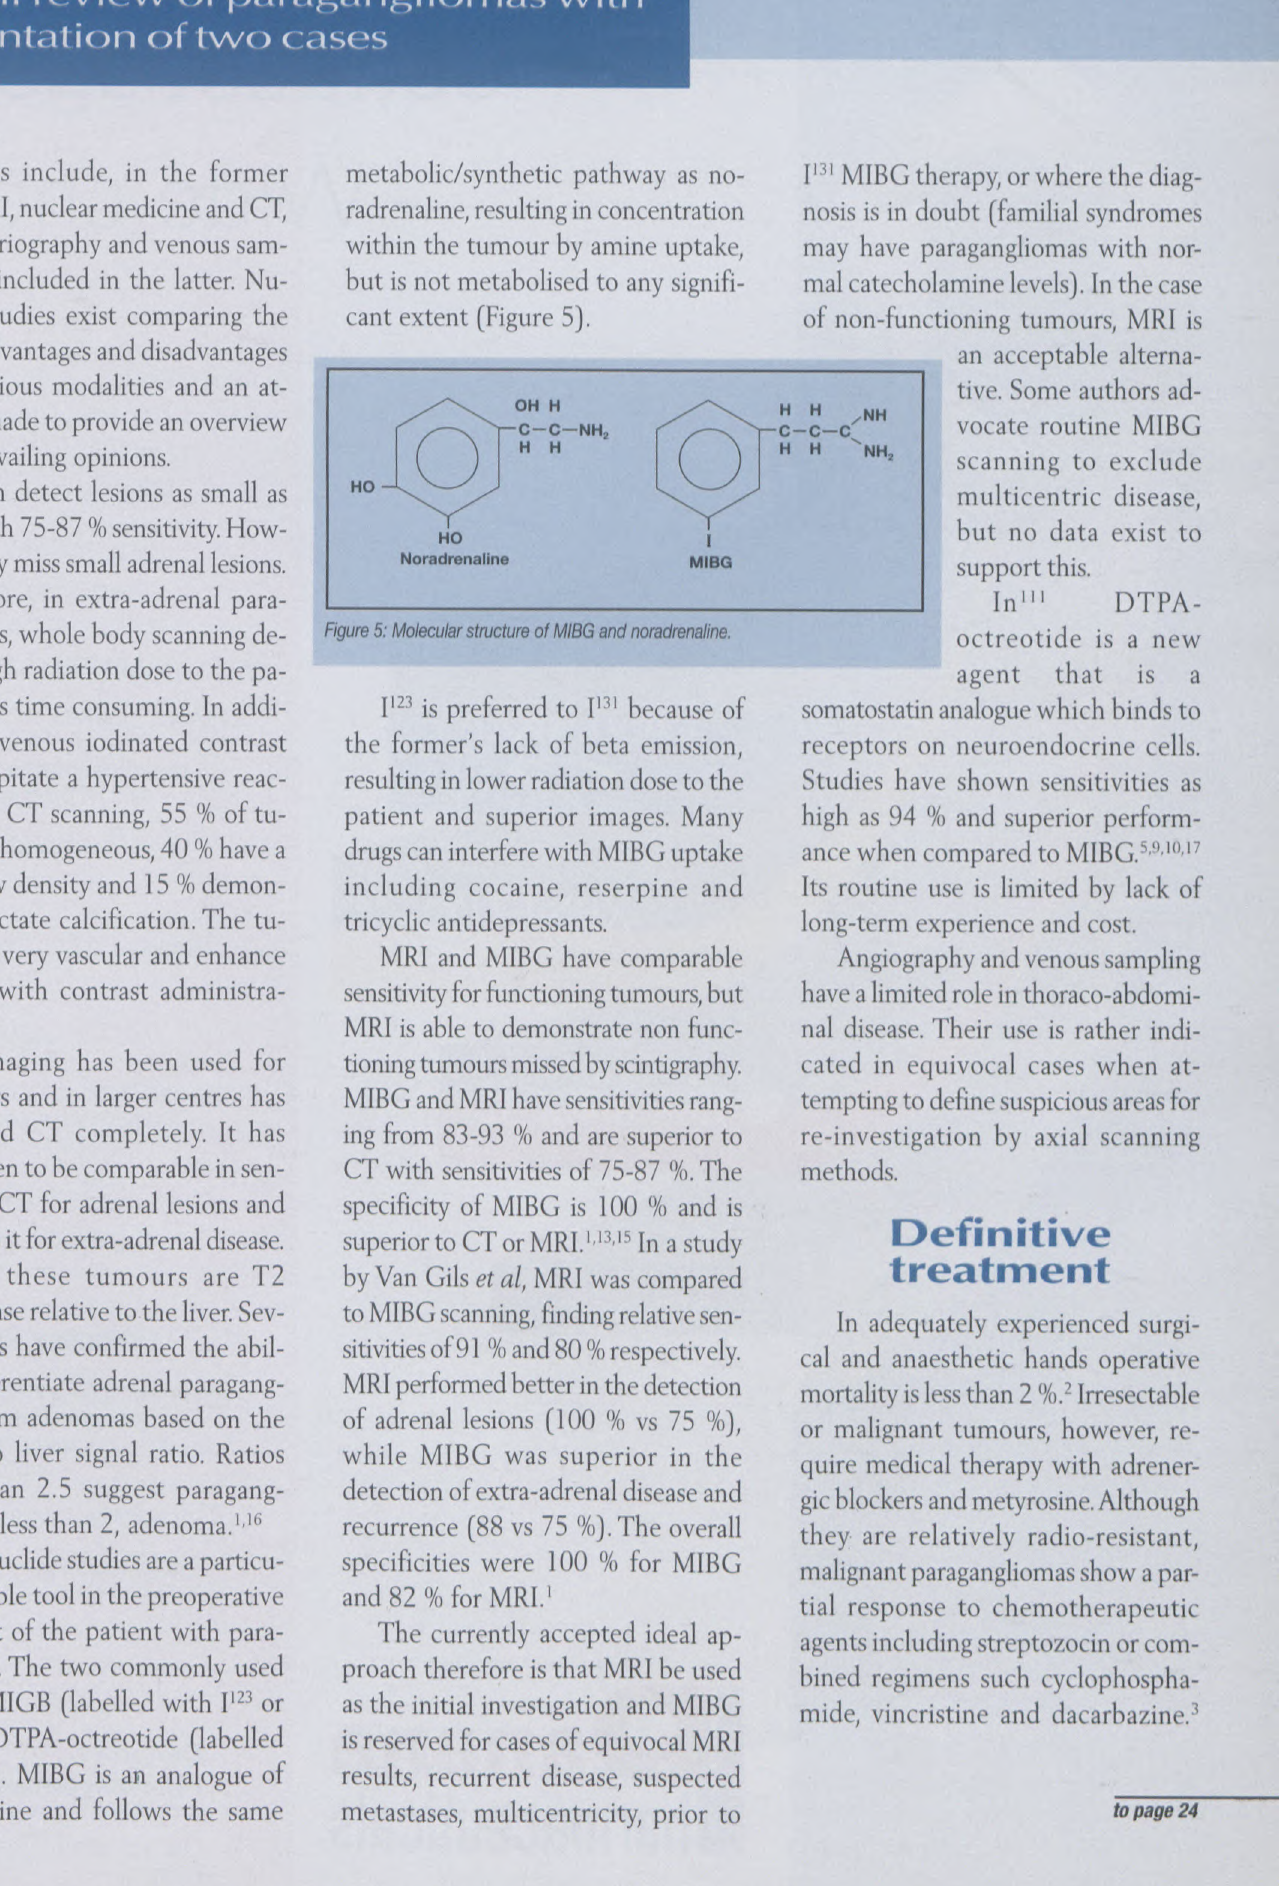
Figure 5: Mo/ecu/ar structure of M/BG and